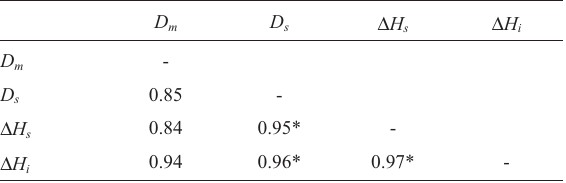
Table 2 - Pearson correlation coefficients among the multilocus genetic distance ( D m ), Nei’s standard genetic distance ( D s ), the increase in individual and standard heterozygosities of the crosses ( ∆ H i , ∆ H s